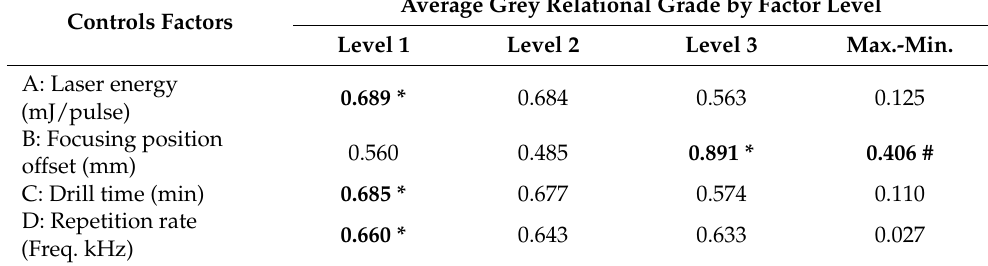
Table 8. Response table for the GRG with equal weighting